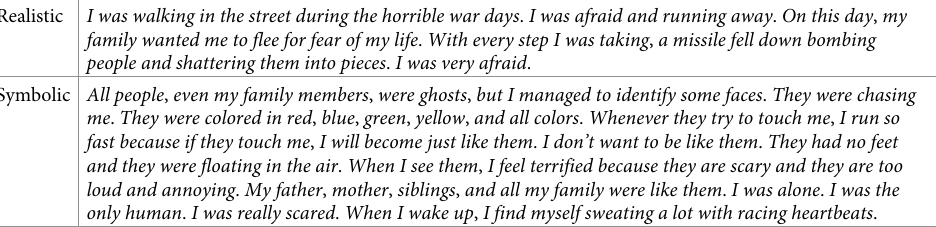
Table 2. Examples of war-affected youth’s nightmares: Realistic and symbolic nightmares. Realistic I was walking in the street during the horrible war days . I was afraid and running away . On this day , my family wanted me to flee for fear of my life . With every step I was taking , a missile fell down bombing people and shattering them into pieces . I was very afraid